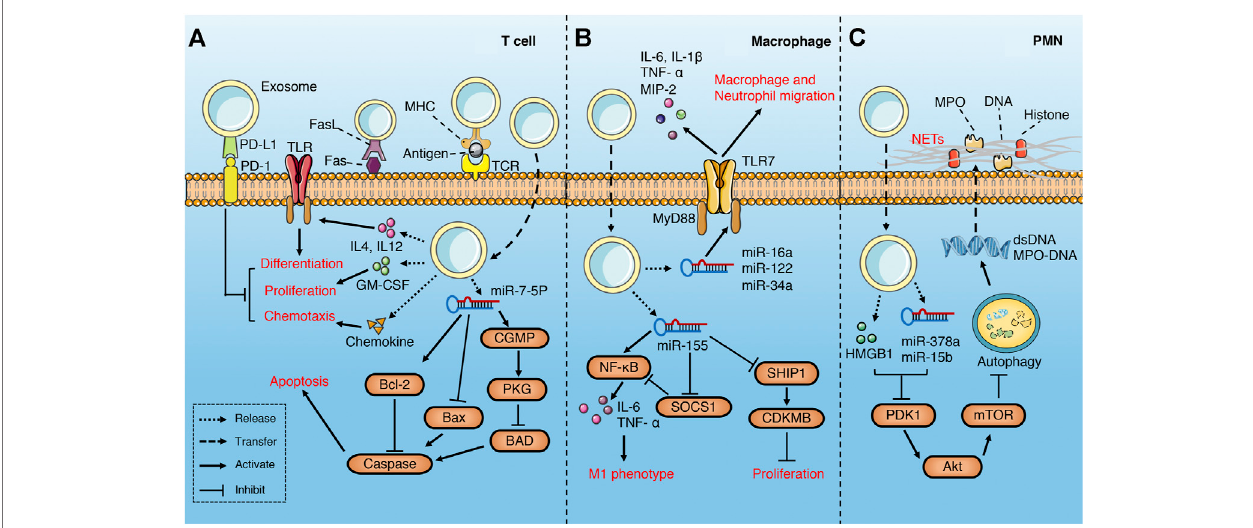
FIGURE 3 | Role of exosomes derived from serum in sepsis. (A) serum exosomes can promote differentiation, proliferation and chemotaxis of T cell via pro- in fl ammatory cytokines, GM-CSF and chemokines separately, while play the opposite role through PD1/PDL1 pathway. In addition, exosomes may attenuate T cell